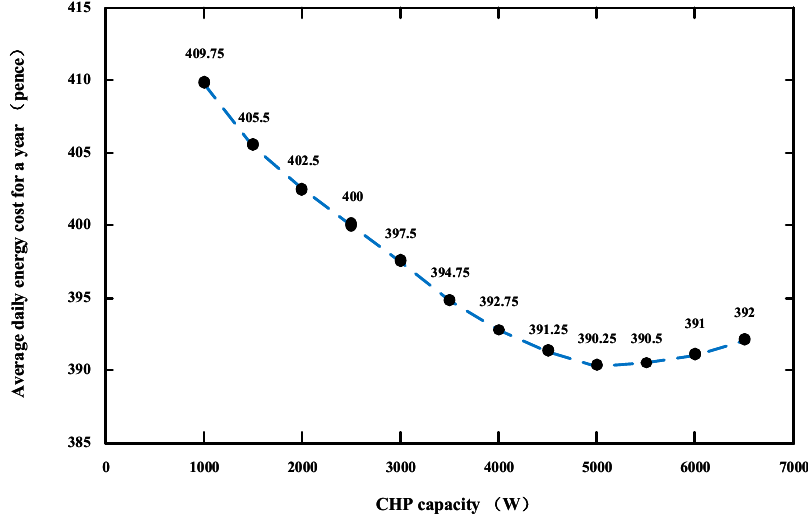
Figure 11. Average daily energy costs of a terraced house for installing different capacities fuel cell CHP.